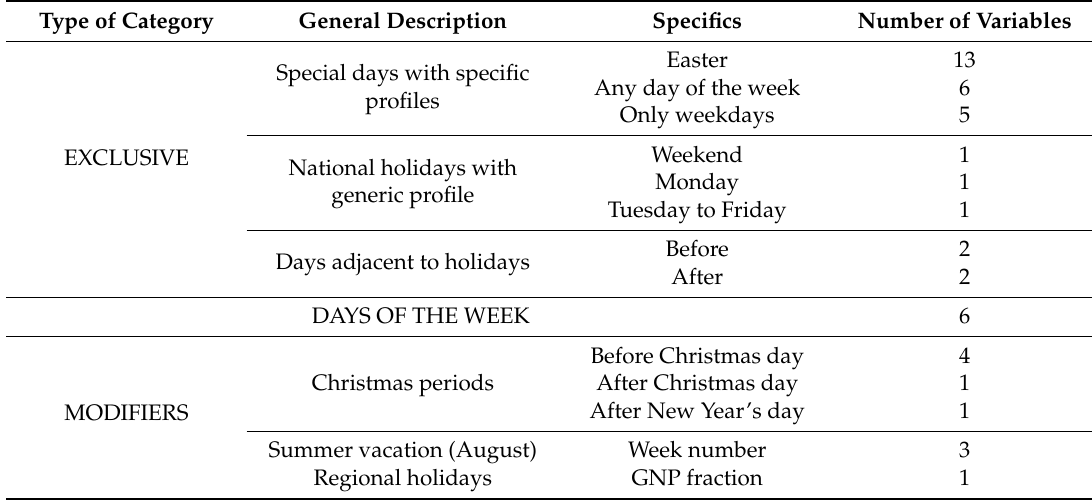
Table 5. Types of day category